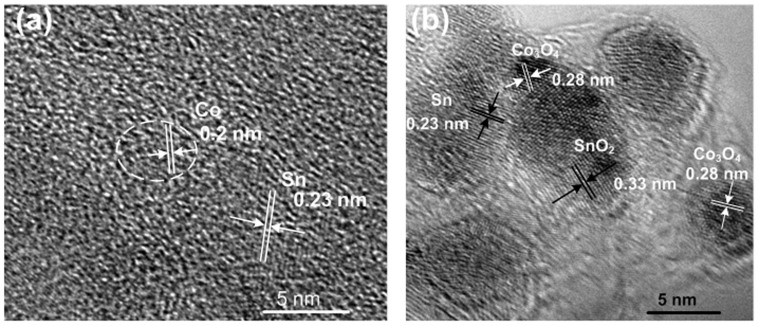
HRTEM images of SnO2/Co3O4/rGO electrode (a) discharged to 0.01 V and (b) charged to 3 V after 20 cycles.